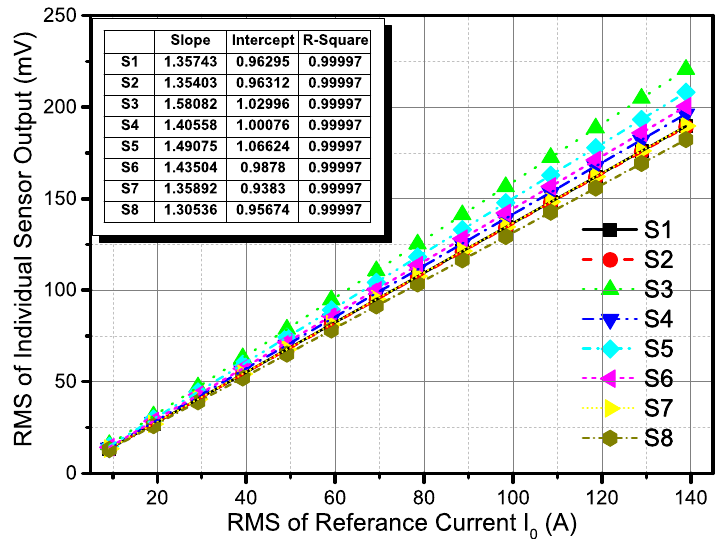
Figure 6. Calibration result for individual outputs of sensors. The results of the linear fit for individual sensors are listed in the table.